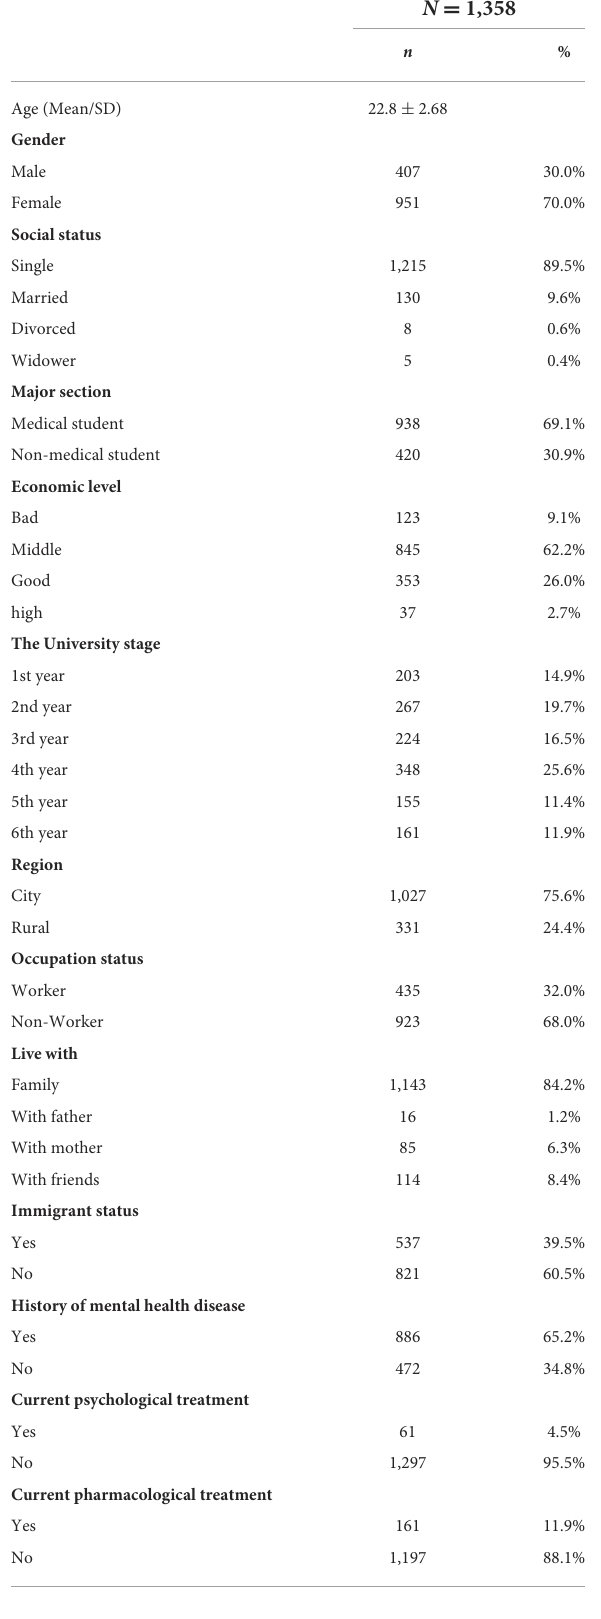
TABLE 1 Baseline characteristics of the